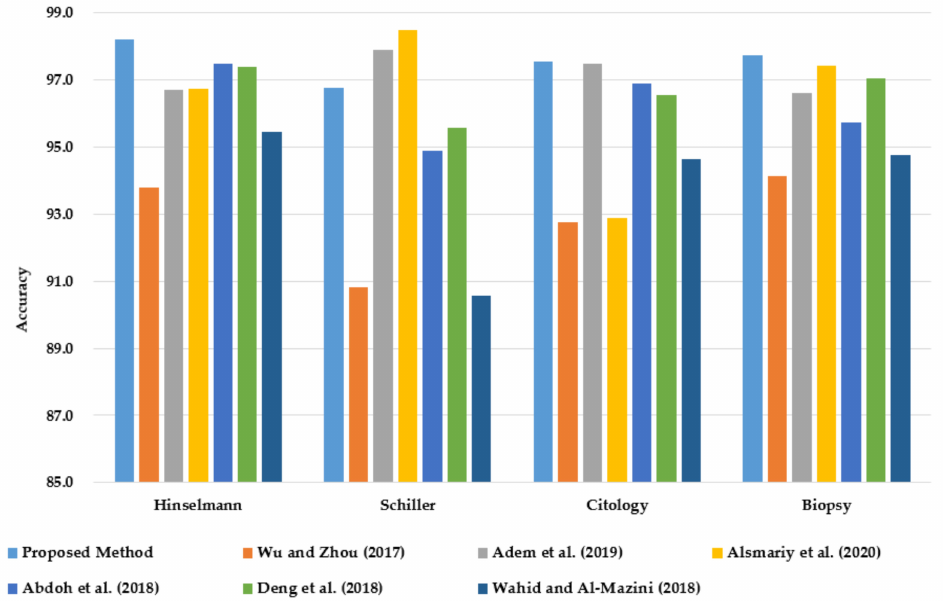
Figure 7. Comparison of classification accuracy of PCA–GA–MLP with the best methods in the literature in diagnosing cervical cancer using the benchmark dataset from